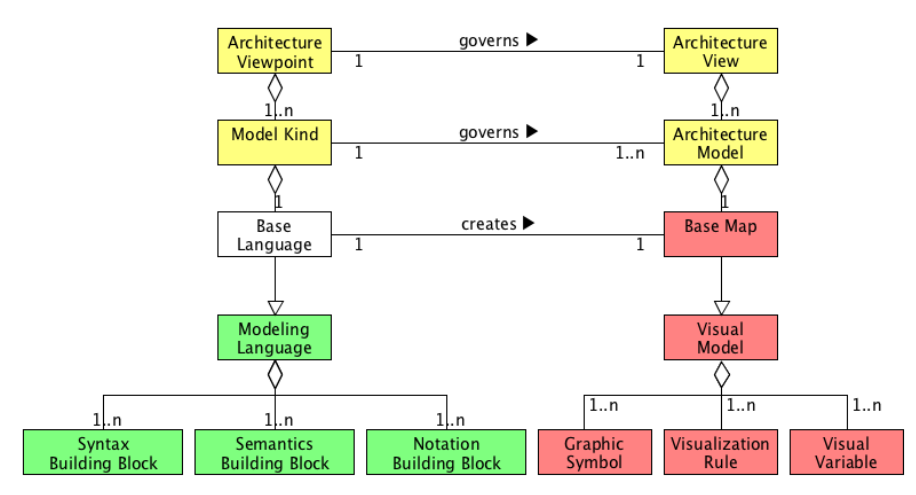
Figure 3. Integration of the extensions of Architecture Viewpoint and Architecture